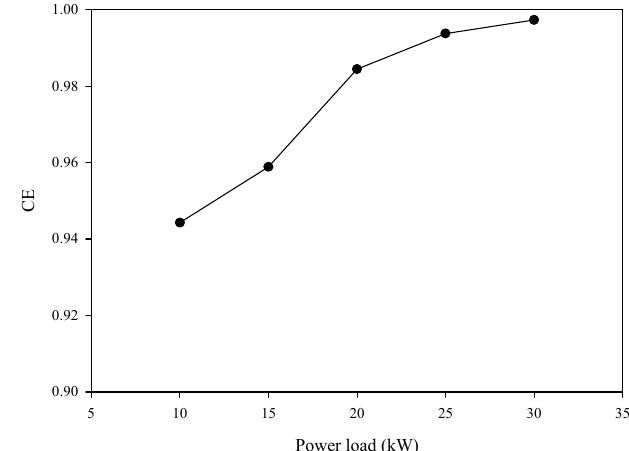
Figure 5. Combustion efficiency (CE) of the micro gas turbine generator using biogas for test operation. (CE = CO 2 /(CO 2 +CO); data from Table 3).